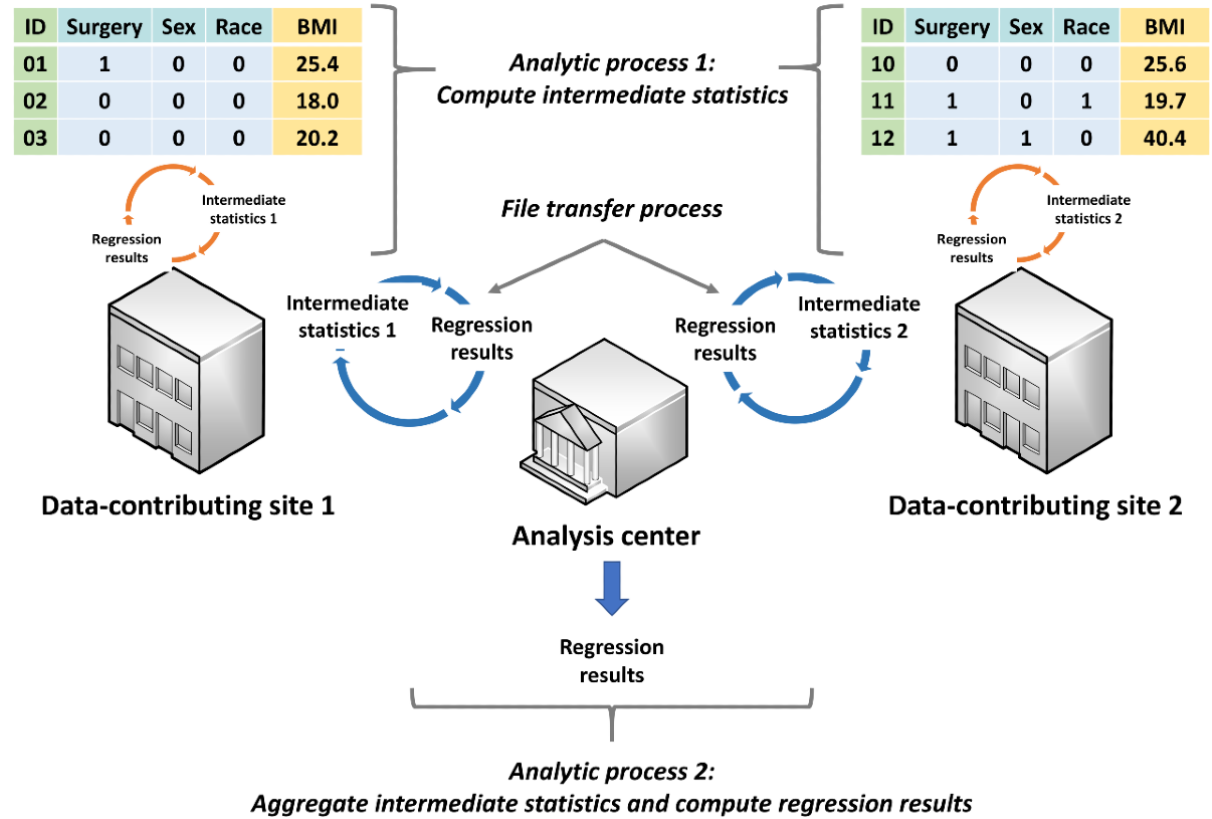
Figure 1. Distributed regression analysis in horizontally partitioned data environments. In this hypothetical example, surgery, sex, and race are the independent variables, while BMI is the dependent variable. Both data-contributing sites have the same set of